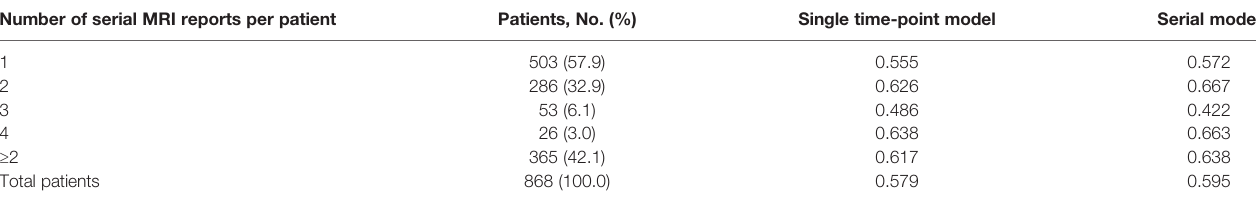
TABLE 2 | C-index comparison between serial and single time-point models based on visit counts using ClinicalBERT.